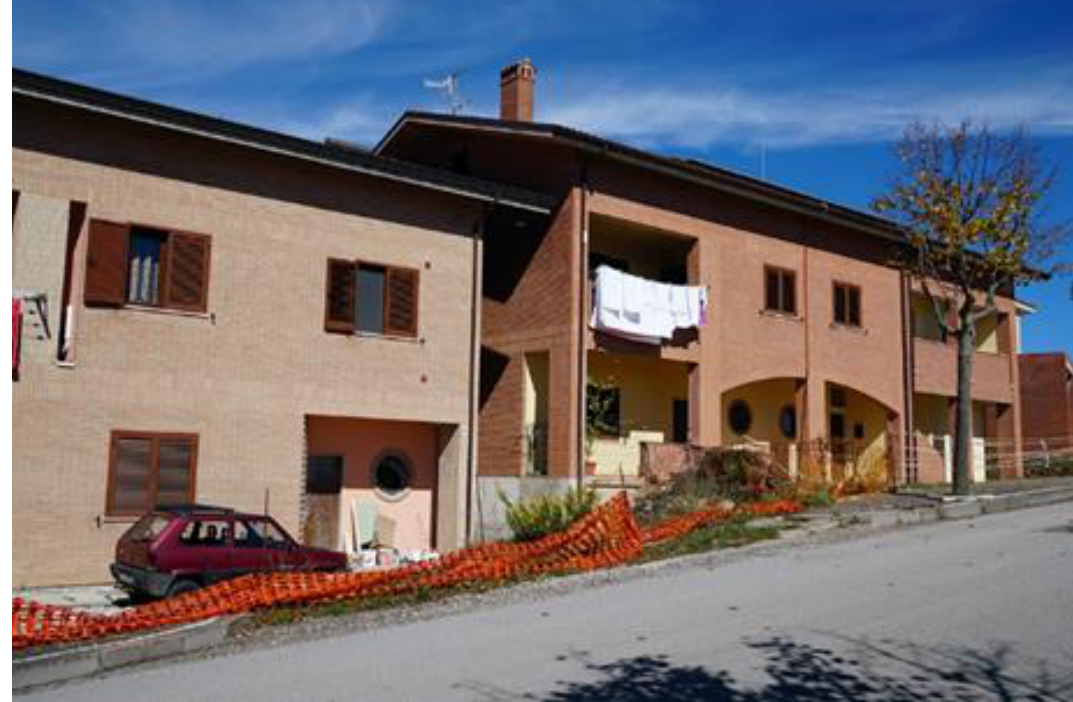
Figure 89. Romagnano al Monte: details of new buildings in the new town (photos by [35,36]).